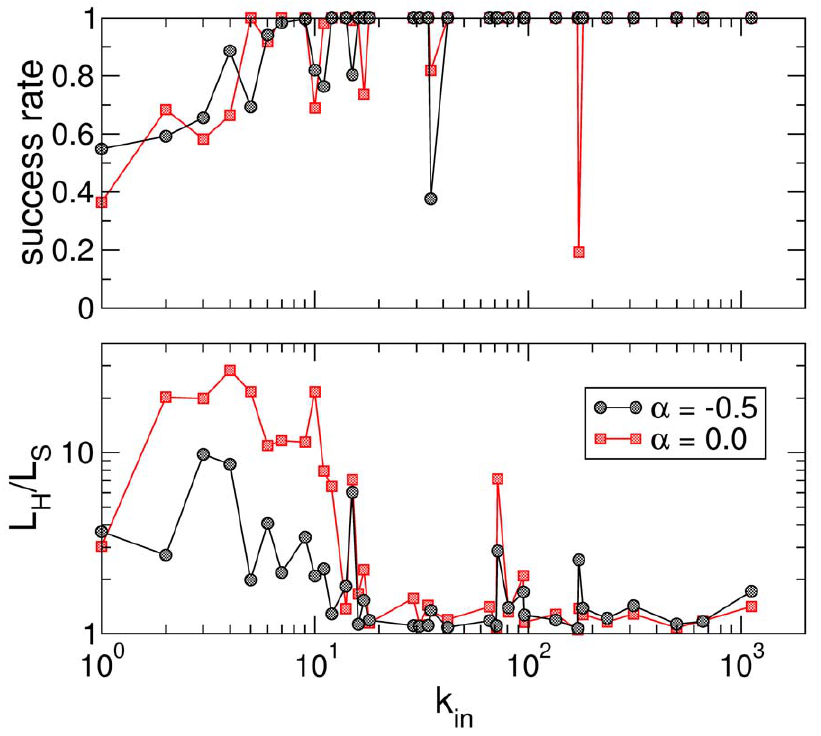
Figure 3. Success ratio of semantic paths reaching the destination (upper panel), and length ratio compared (lower panel) as a function of target’s accessibility represented by its in-degree k in